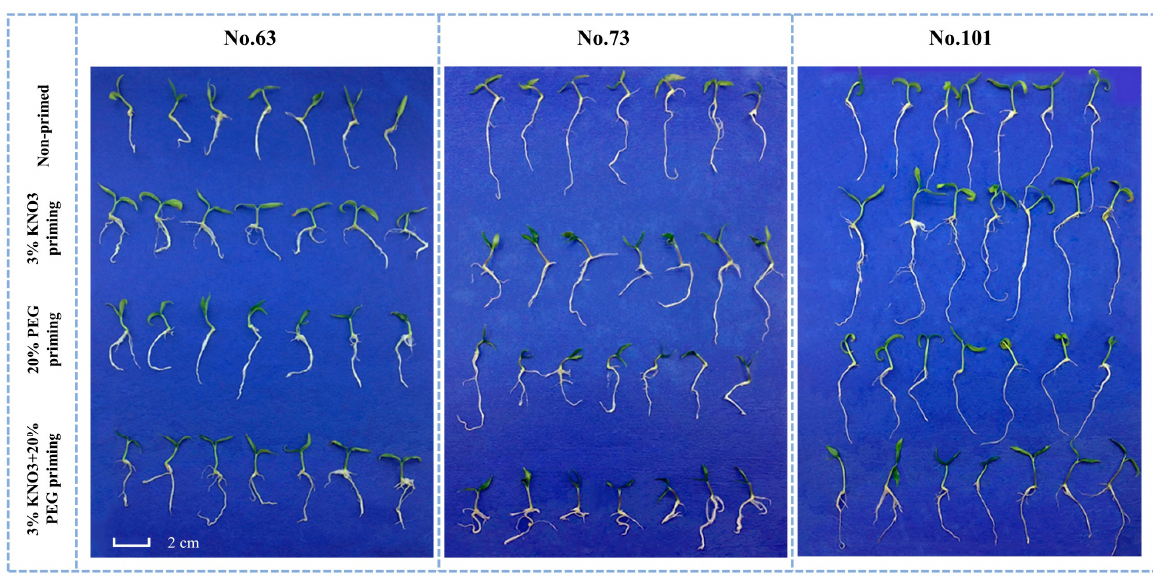
Figure 2. Growth of pepper seedlings under three priming treatments.